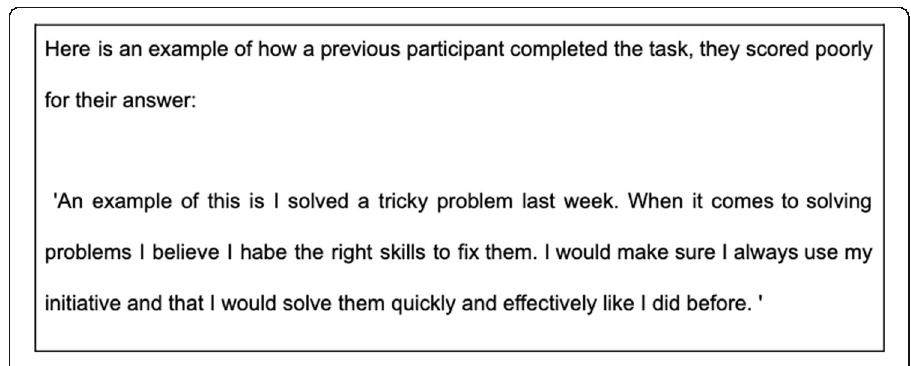
Fig. 2 Previous participants answer (Low level of success version)